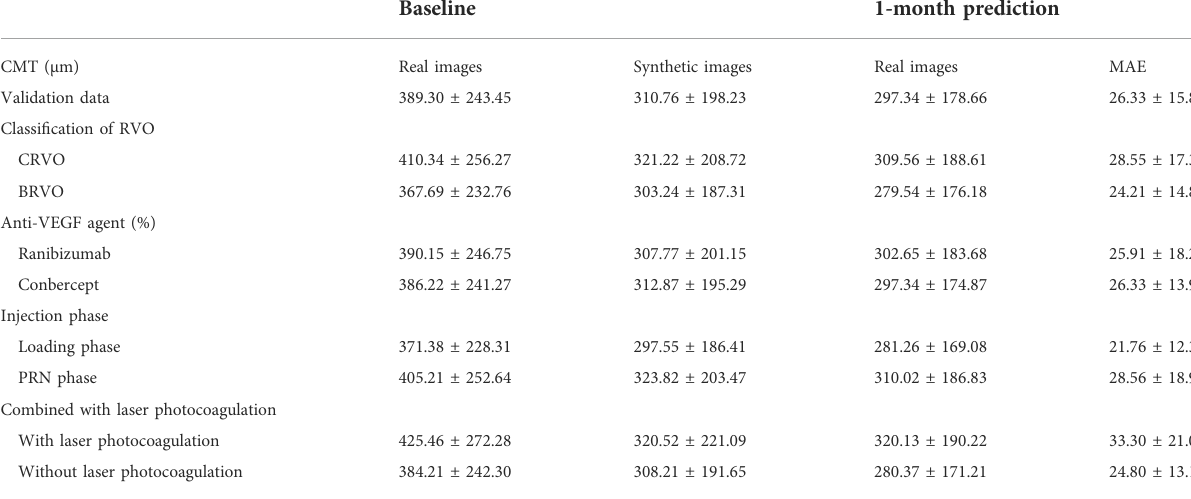
TABLE 2 Accuracy of the synthetic post-therapeutic OCT images of RVO in the evaluating